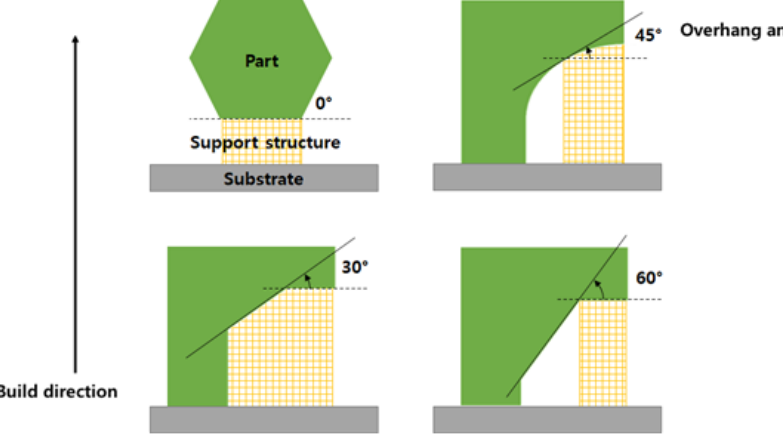
Figure 1. Overhang angle and support of part fabricated via additive manufacturing. This indicates that an overhanging part in the vicinity of the support is partially supported by its geometry, although the overhang angle of the part is much smaller than the critical angle. Figure 2 shows an example of an unsuccessful fabrication and a residual overhanging structure. Based on the remaining part, an overhanging part is supported by an adjacent stable structure around the boundary edge. The effect of support must be considered when determining the actual collapse